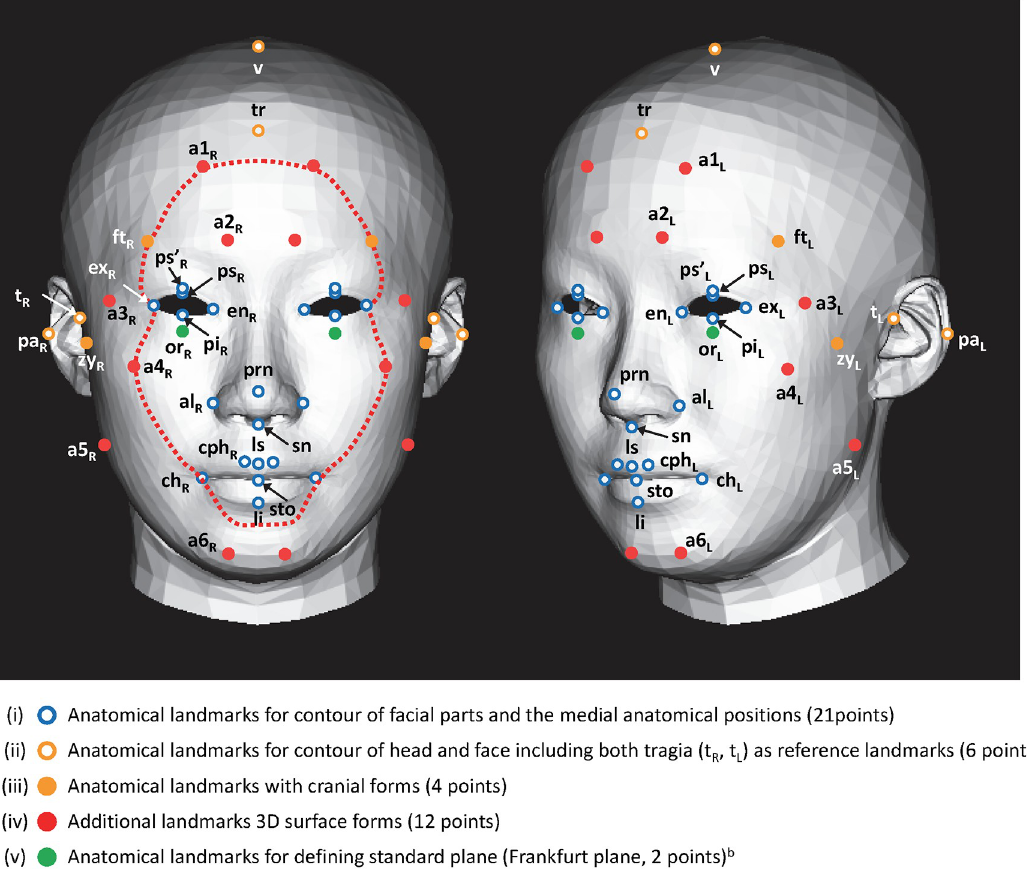
Fig 1. Landmarks for polygon modeling a . a Identical frontal and rotated [30˚, left side] views of polygon models (averaged form) used in the present study. The abbreviations for the right and medial landmarks were indicated in the frontal view, and those for the left and the medial landmarks were indicated in the rotated view of the polygon models. The red dotted line represents a contour line in the z -axis that passes along both ectocanthions (lateral corners of the eyes, see Supporting Information 1–2) to describe the locations of the landmarks a4 R and a4 L . This line was not used in the analysis. b These landmarks were not used to create the homologous polygon